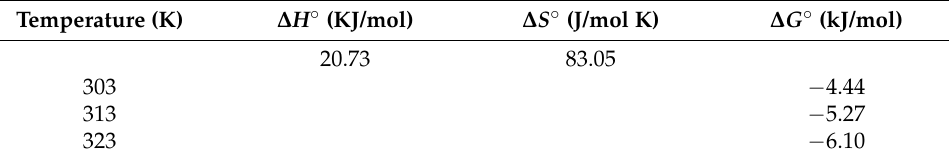
Table 5. Fluoride adsorption thermodynamic parameters.